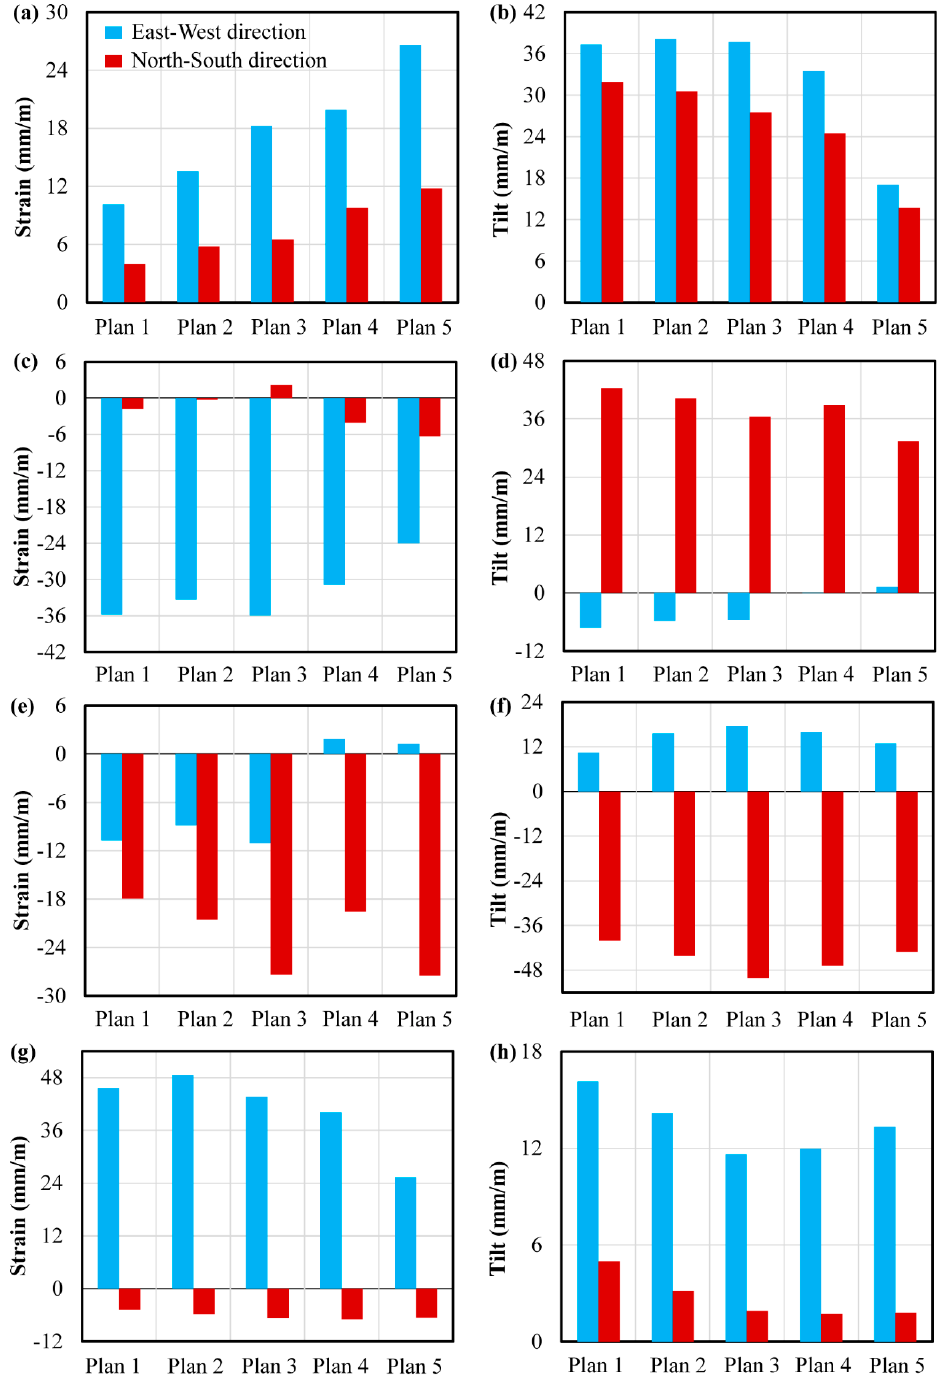
Figure 7. The average horizontal strain and tilt in the area containing: ( a , b ) Pylon 37#, ( c , d ) Pylon 36#, ( e , f ) Pylon 53#, and ( g , h ) Pylon 103# at mining distance of 500 m. The areas are 10 m square.